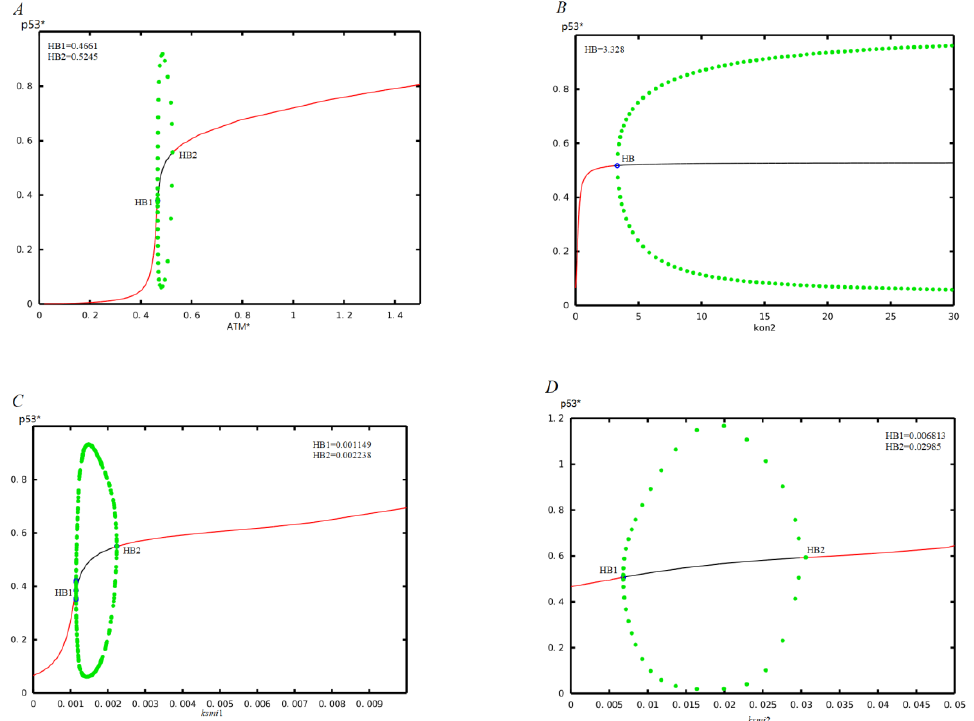
Figure 3. The bifurcation diagram of p53* concentration and model parameters. ( A ), ( B ), ( C ) and ( D ) correspond to the parameters ATM*, k on2 , k smi1 and k smi2 , respectively.